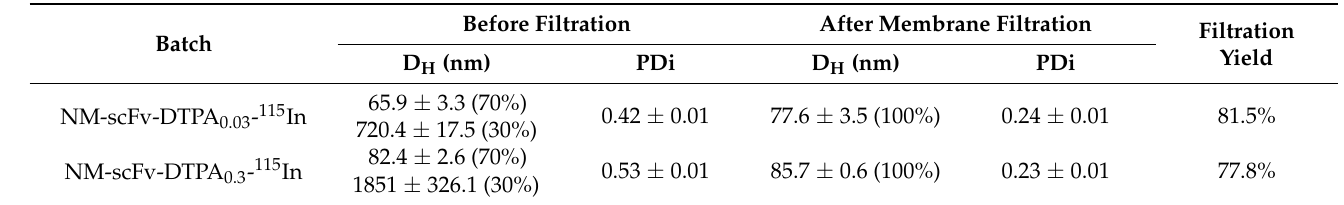
Table 5. Hydrodynamic size of different batches of NM-scFv-DTPA- 115 In before and after membrane